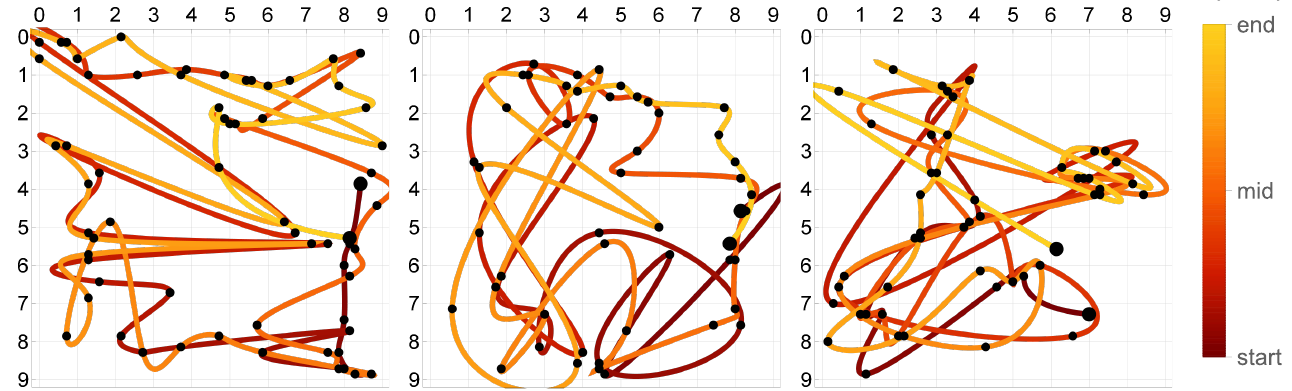
Figure 7. The trivial F 1 -optimum trajectories. The black dots correspond to the 1 Hz time sampling, while the line in-between is the 3rd-order spline interpolation. The actual trajectories were: ( a ) square, ( b ) circle, and ( c )